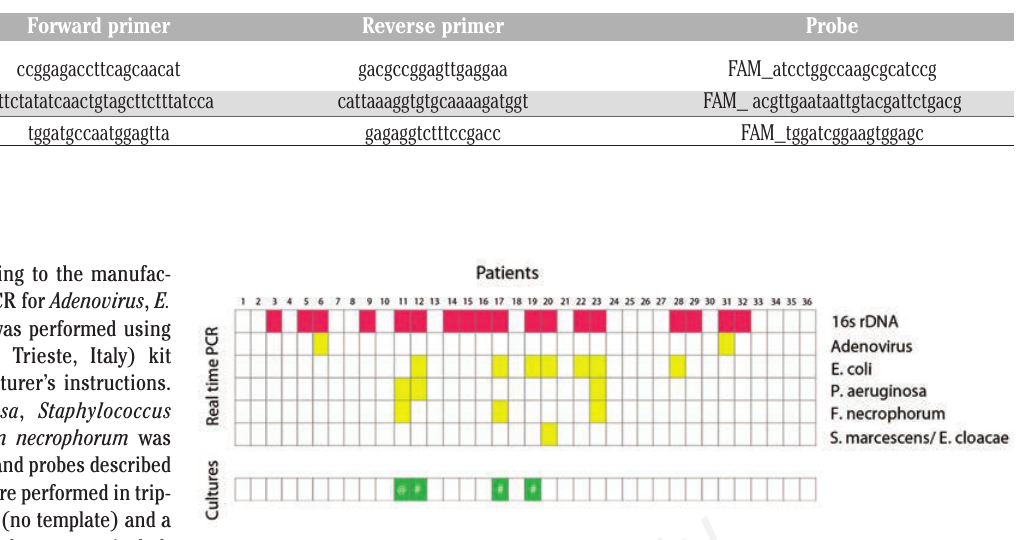
Table 1. Real-time polymerase chain reaction primers.